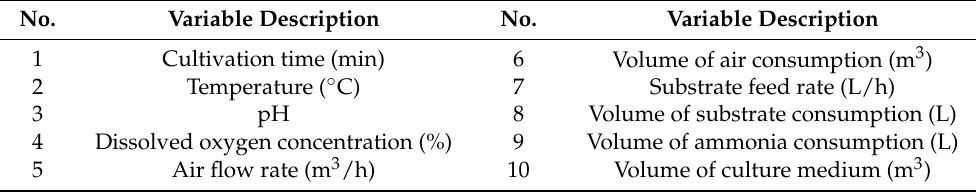
Figure 9. Flow diagram of an industrial fed-batch CTC fermentation process. Table 3. Input variables for soft sensor development in the industrial CTC fermentation process.